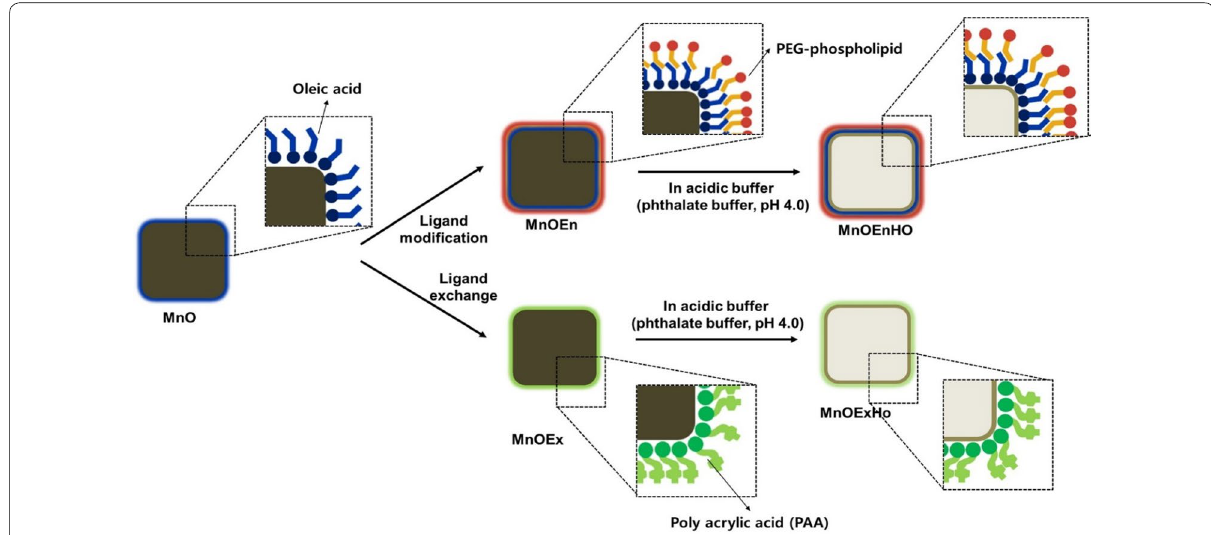
Fig. 1 Schematic of the synthetic procedure of MnOEn, MnOEnHo, MnOEx and MnOExHo using